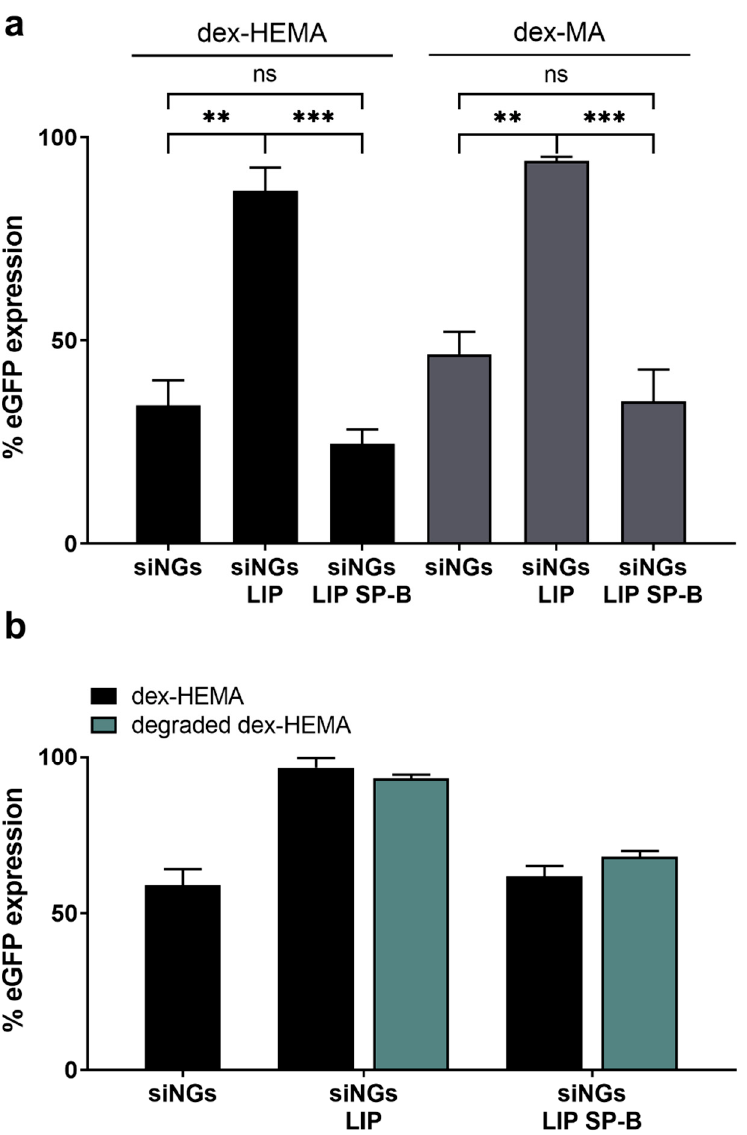
Figure 6. Impact of dextran nanogel core structure on SP-B mediated siRNA delivery. ( a ) Gene silencing potential of (proteolipid-coated) siRNA-loaded NGs (siNGs) constructed with the hydrolysable dex-HEMA or the stable dex-MA. Both formulations were coated with a mixture of DOPC:PG (85:15 wt%) here abbreviated as LIP, with or without SP-B. Although the stable dex-MA shows a less pronounced eGFP knockdown, SP-B promotes siRNA delivery equal to the degradable dex-HEMA. Data are a summary of two independent experiments. Data are represented as the mean ± SD ( n = 2) and statistical significance is indicated (** p < 0.01, *** p < 0.005, ns = not significant). ( b ) Gene silencing of (proteo)lipid-coated dex-HEMA NGs with an intact or degraded NG core. All experiments were performed with a fixed NG concentration (30 µ g / mL) and siRNA concentration (5 nM). Data show one representative graph of two independent experiments; formulations with increased SP-B fraction showed the same trend (data not